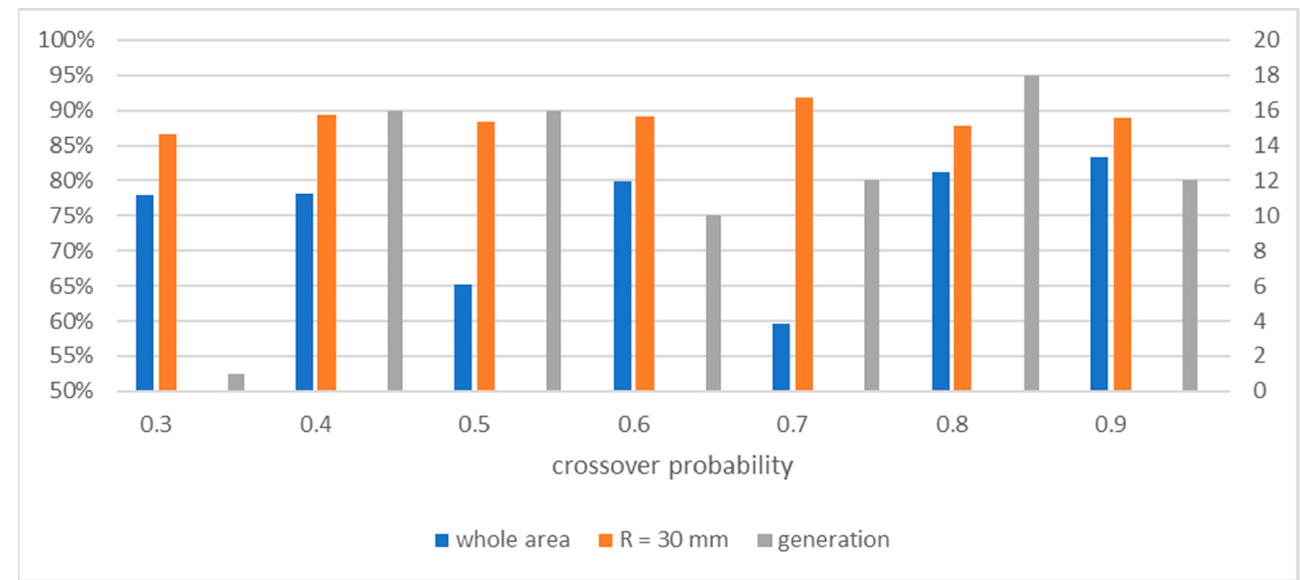
Figure 9. The share of correctly classified markers of the entire pattern and in the area with a radius of R = 30 mm around the center of the marker grid, and the number of the generation in which the genetic algorithm developed the best-suited individual depending on the probability of crossing.